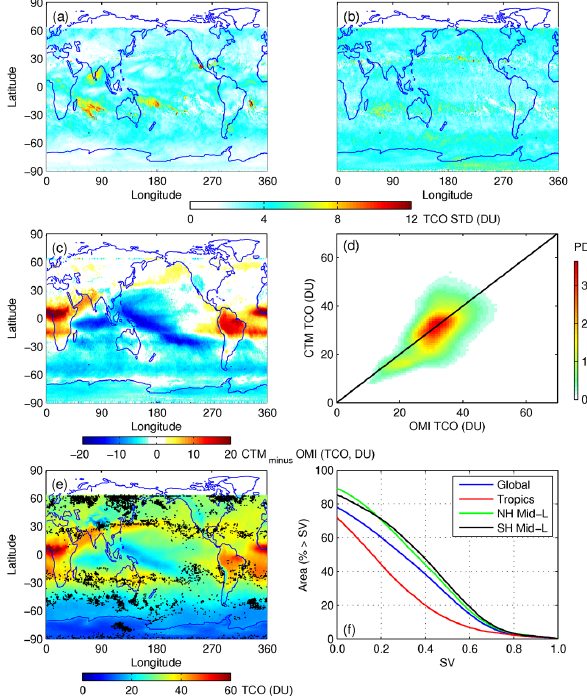
Fig. 5. For June 2005, the standard deviation ( σ ) of TCO (in DU) for (a) CTM and (b) OMI (see text). (c) The bias (unit: DU) of the monthly mean TCO, CTM minus OMI. (d) 2-D probability distribu- tion of N × 10 6 individual comparisons of OMI and CTM TCO. (e) monthly mean CTM TCO (unit: DU) with the locations of SV ≥ 0.70 marked by black dots. (f) Cumulative probability distribution of SV (in (e) and (f), where SV TR and SV EX overlap, smaller values are presented).